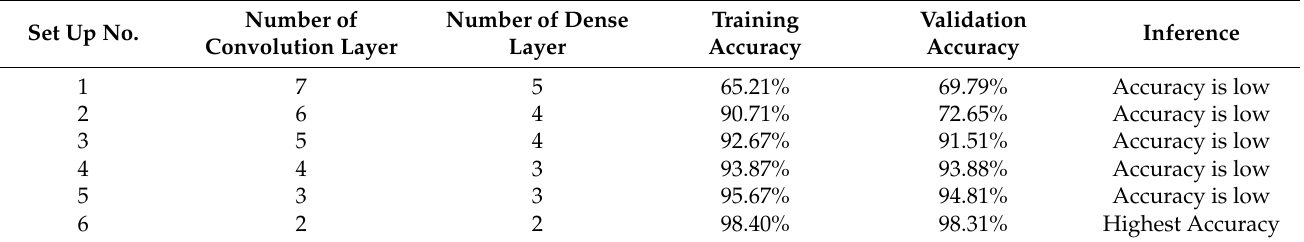
Table 10. Results of ablation study 1, modifying both the number of dense and convolution layers. Set Up No.